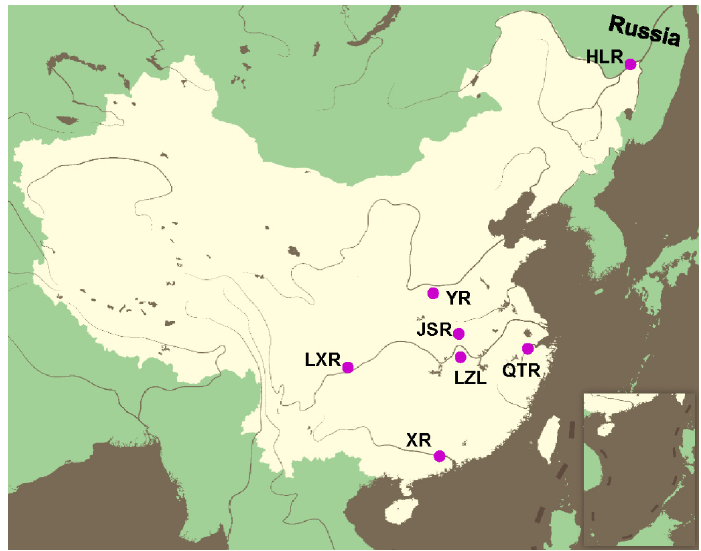
Figure 1. Sampling locations of fish in the genus Megalobrama . HLR, the Heilong River; QTR, the Qiantang River; JSR, the Jinshahe Reservoir; YR, the Yi River; LZL, the Liangzi Lake; LXR, the Longxi River and XR, the Xi River.